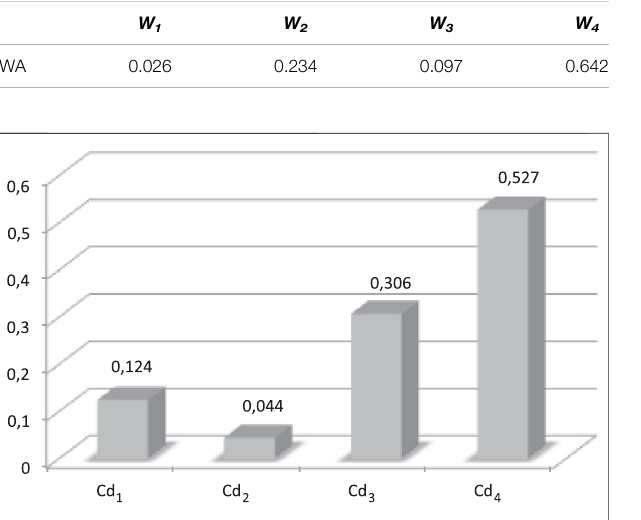
FIGURE 10 | Shapley values for the CI operator.